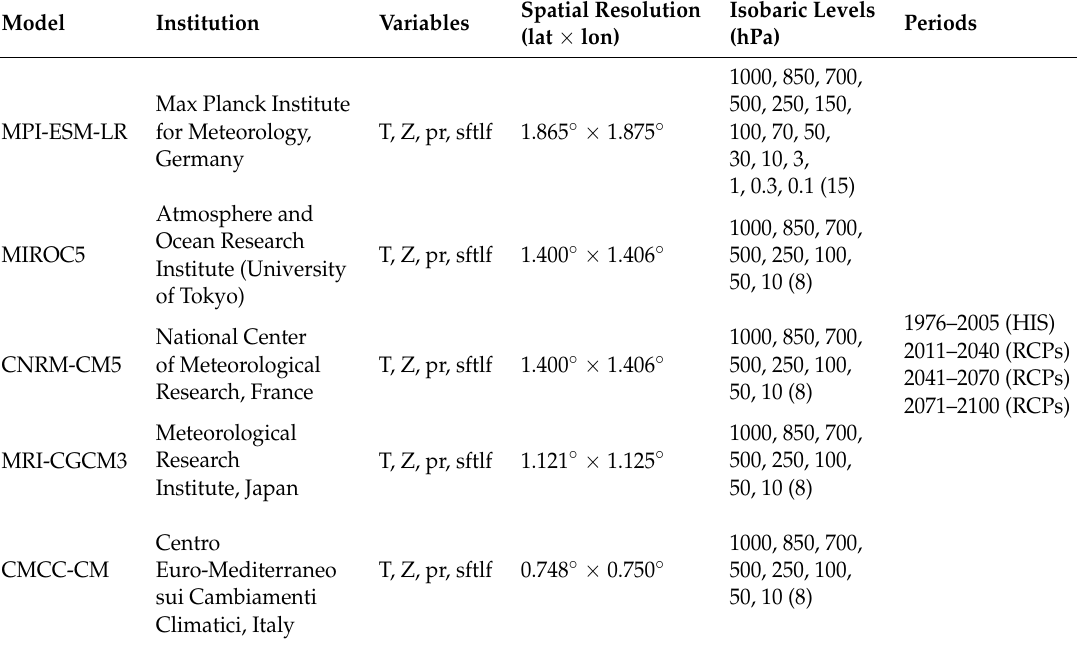
Table 1. Set of Coupled Model Intercomparison Project Phase 5 (CMIP5) models [35] used to characterize the future condition of the H 0 distribution. The variables T and Z correspond to temperature and geopotential height at isobaric levels. The variables pr and sftlf represent precipitation rate and fraction of land area,